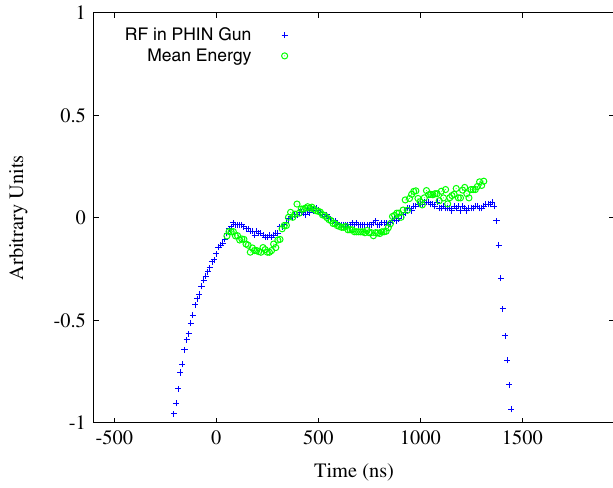
FIG. 16. Deviation of the mean energy in correlation with the rf amplitude pulse shape.